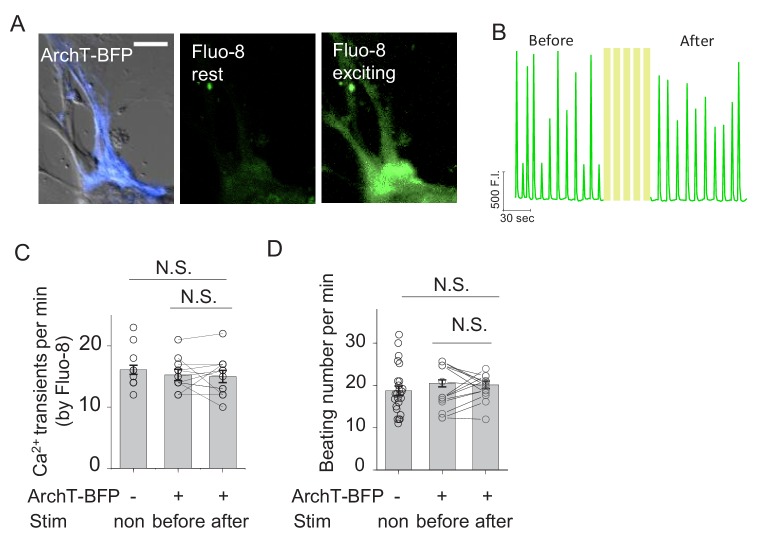
Spontaneous Ca2+ transients and beating rate in rat cardiomyocytes expressing ArchT.(A) Example images of a cardiomyocyte (CM) expressing ArchT (left), showing Fluo-8 fluorescence at the rest state (middle) and the exciting state (right). (B) Ca2+ transients measured using Fluo-8 fluorescence in the same CM shown in (A) before and after light stimulation. (C–D) Summary of the rate of Ca2+ transients measured with Fluo-8 (C) and the beating rates (D) from untransfected CMs and ArchT-expressing CM before and after light stimulation (n = 11–26 cells per group); cells were stimulated with 20 s pulses at 0.1 mW with 2 min intervals for five repeats. The scale bar represents 50 μm. NS., not significant (p>0.05).